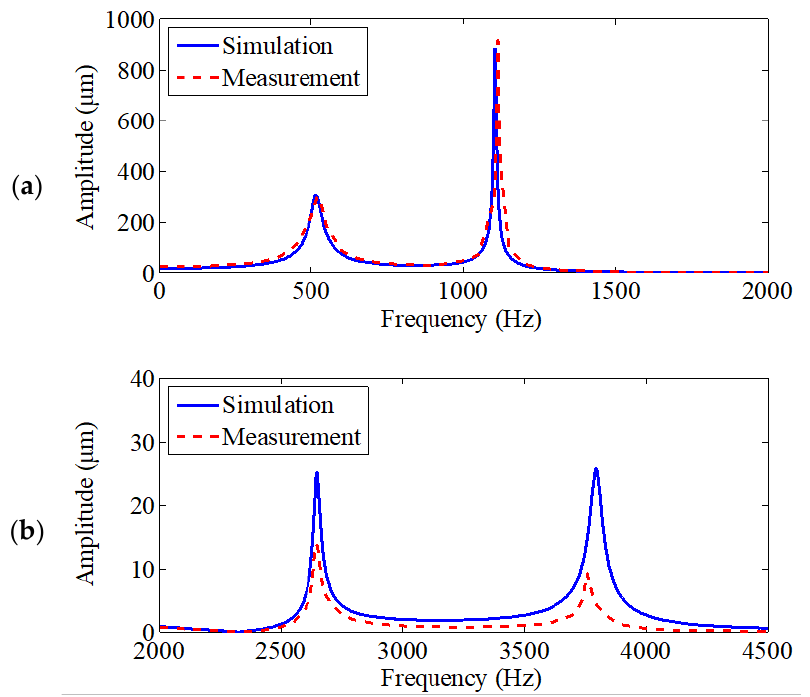
Figure 4. Calculated and tested amplitude – frequency response of torque motor without MF. ( a ) 0~2000 Hz; ( b ) 2000~4500 Hz.